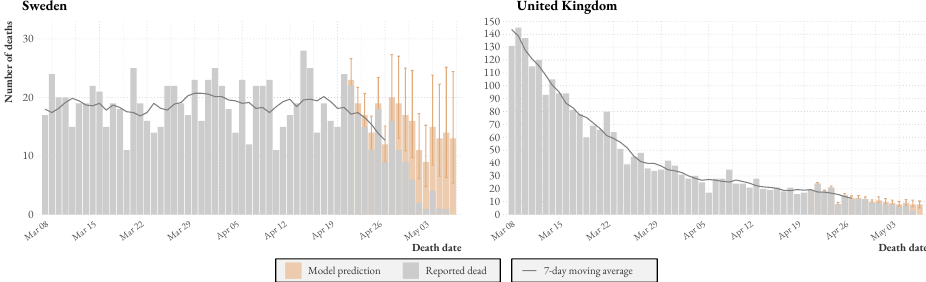
Figure 2. Reported Swedish and UK COVID-19 deaths as of 6 May 2021 and model predictions. Model